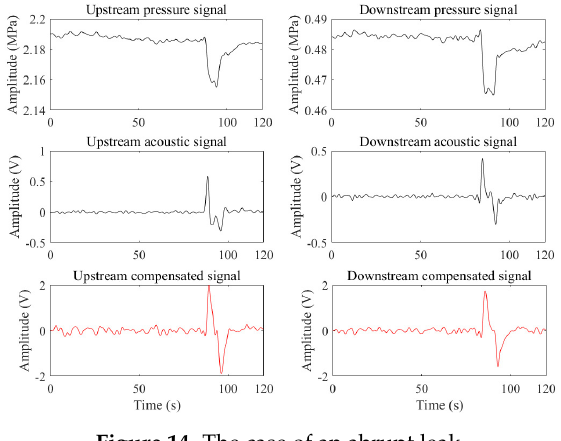
Figure 14. The case of an abrupt